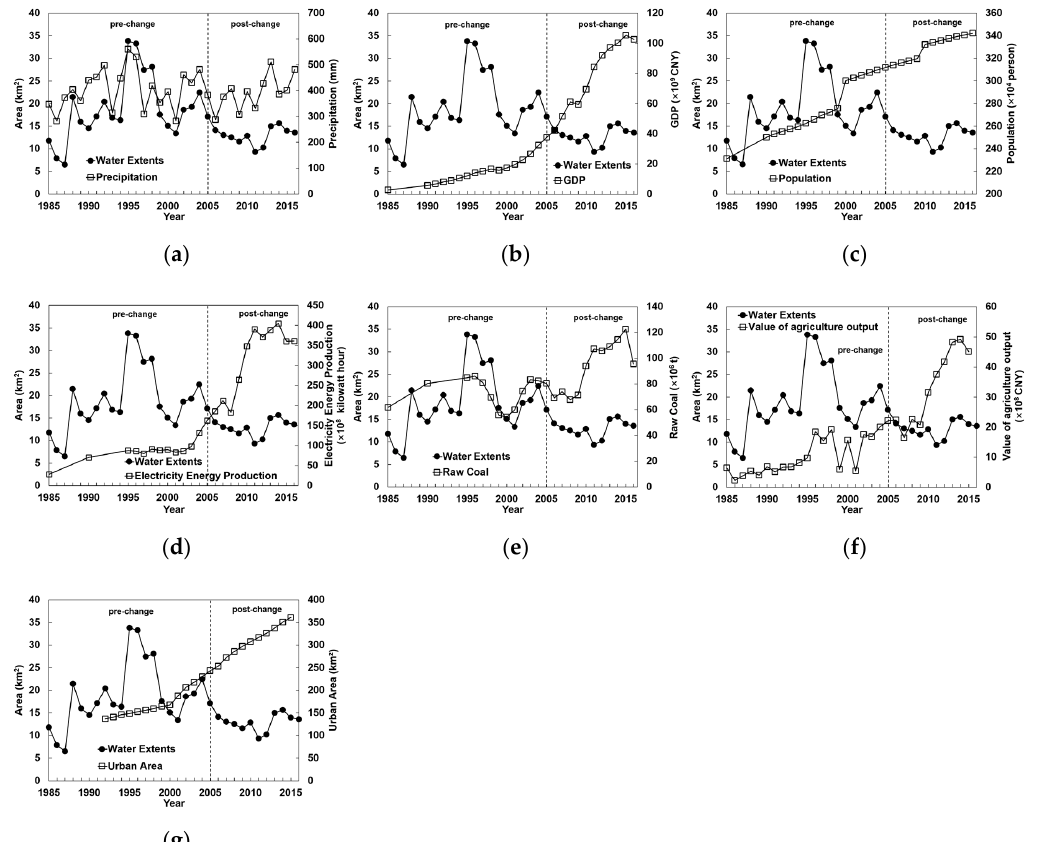
Figure 9. Temporal trends of ( a ) precipitation, ( b ) GDP, ( c ) population, ( d ) electricity energy production, ( e ) raw coal production, ( f ) value of agriculture output and ( g ) urban area, compared to reservoir water extents in the Cetian